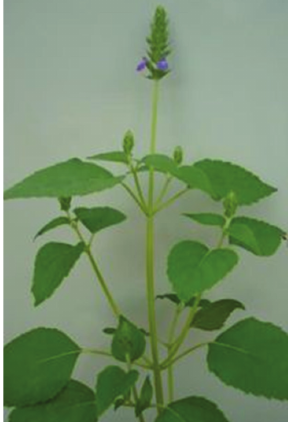
Figure 1: Salvia hispanica L. plant with purple flower and large leaves